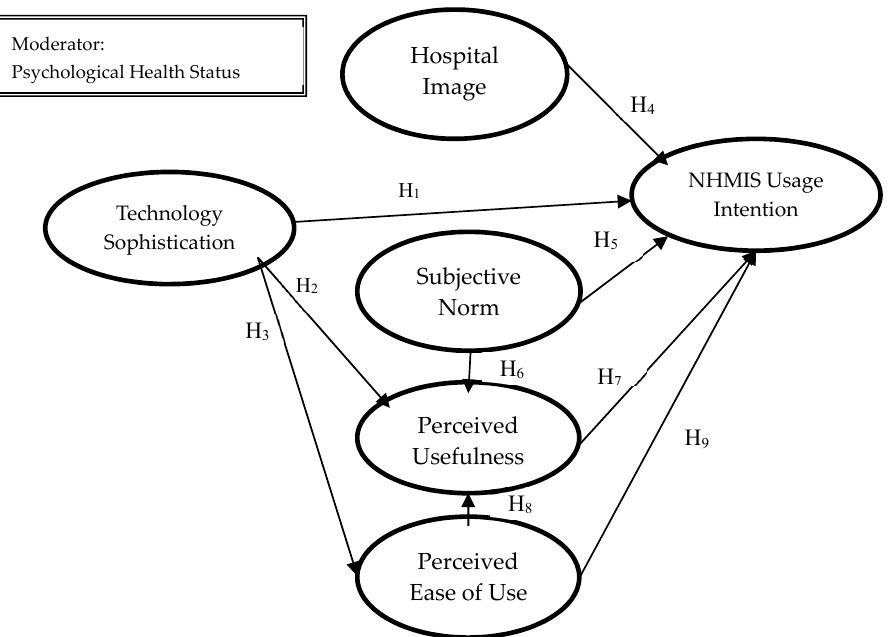
Figure 1. Research Framework. NHMIS, nurse healthcare management information system.